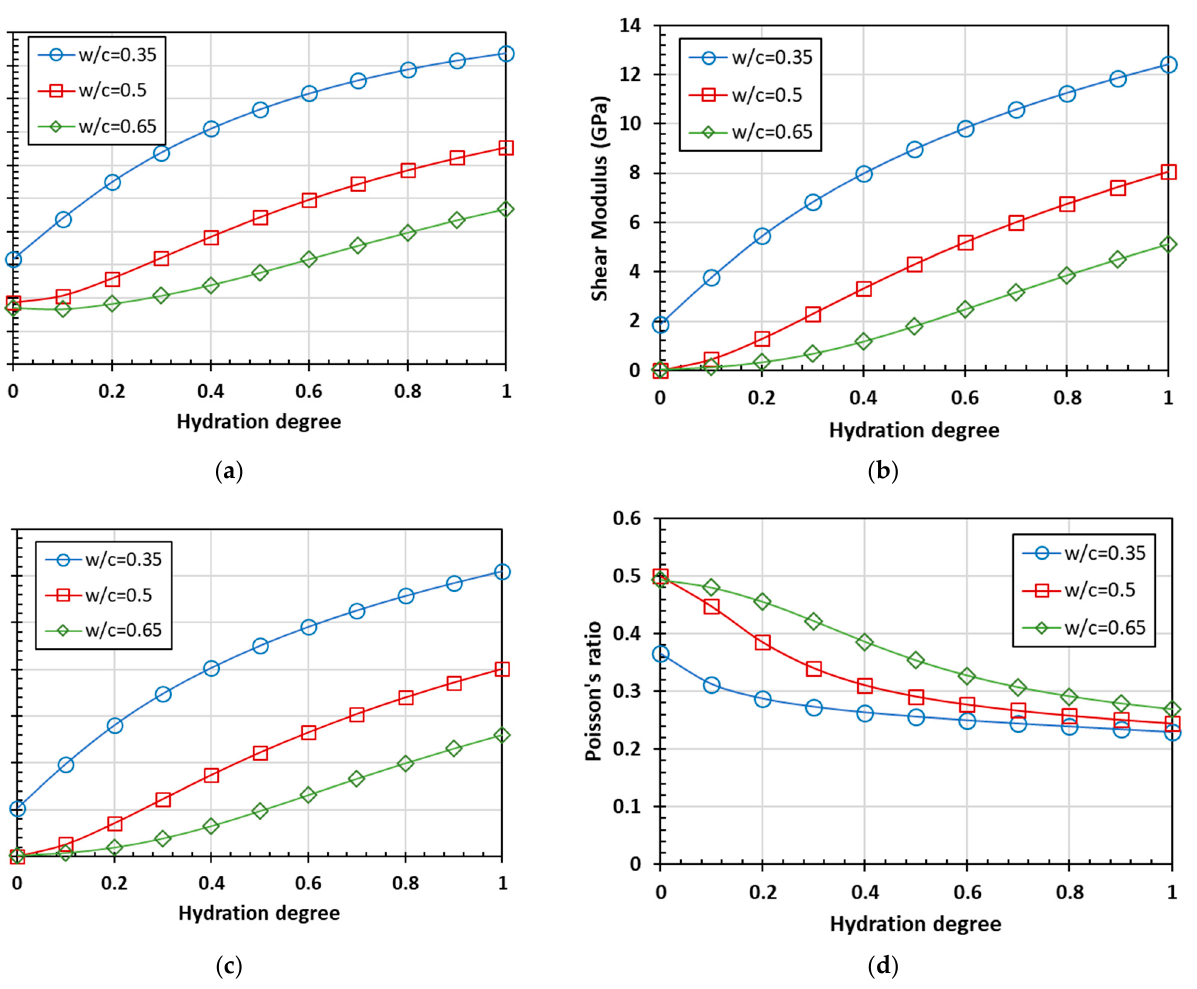
Figure 3. The prediction of elastic parameters based on the homogenization process: ( a ) bulk modulus; ( b ) sheer modulus; ( c ) elastic modulus; and ( d ) Poisson’s ratio.